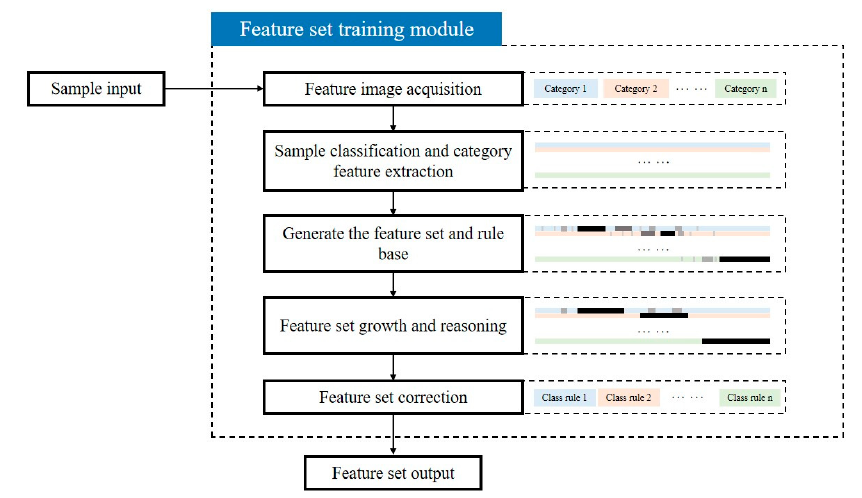
Figure 3. The flow of the feature set training module.